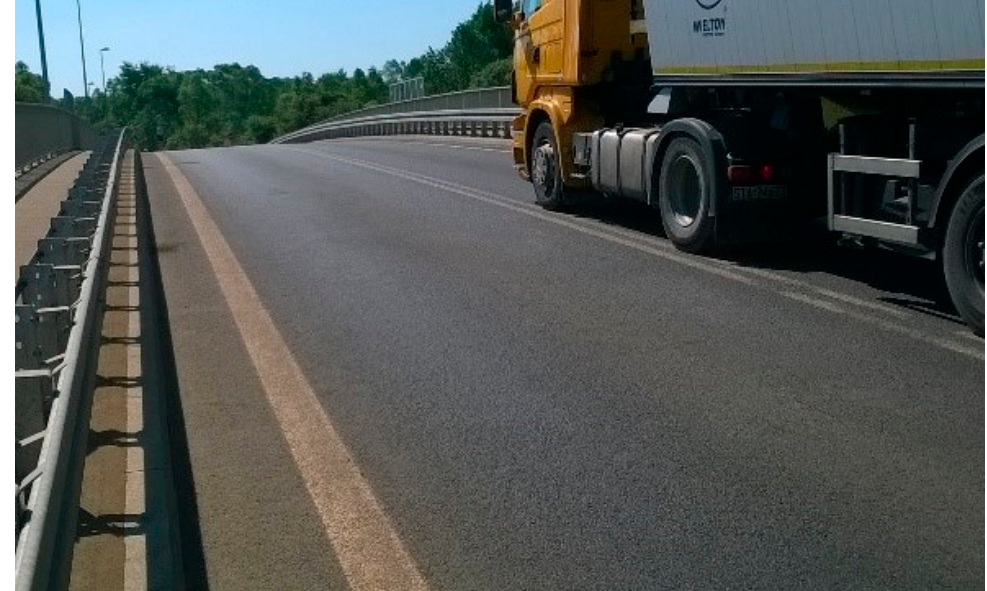
Figure 10. Current condition of pavement with the protective layer made of stone mastic asphalt rich in bitumen mastic (SMA-MA) 11 mixture on the overpass in Police after 5 years of operation.